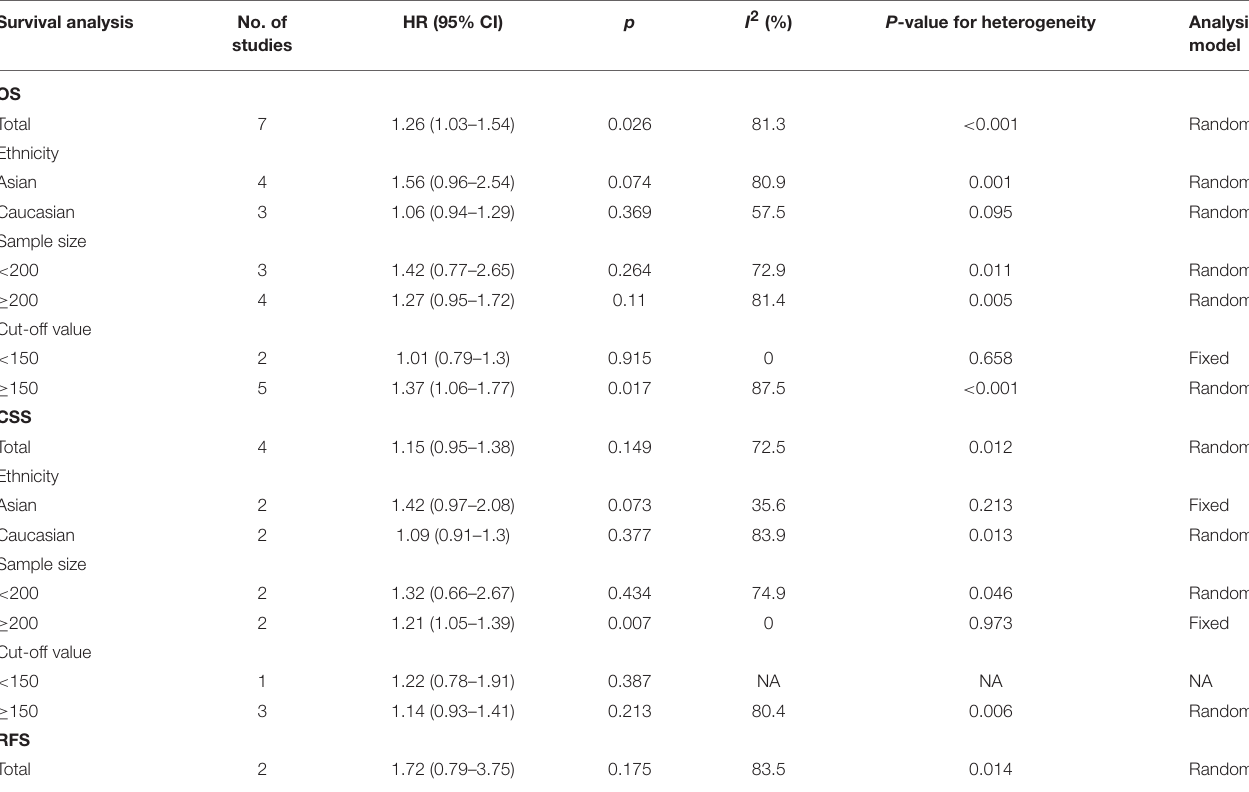
TABLE 2 | Subgroup analysis of the association between PLR and OS, CSS, RFS. Survival